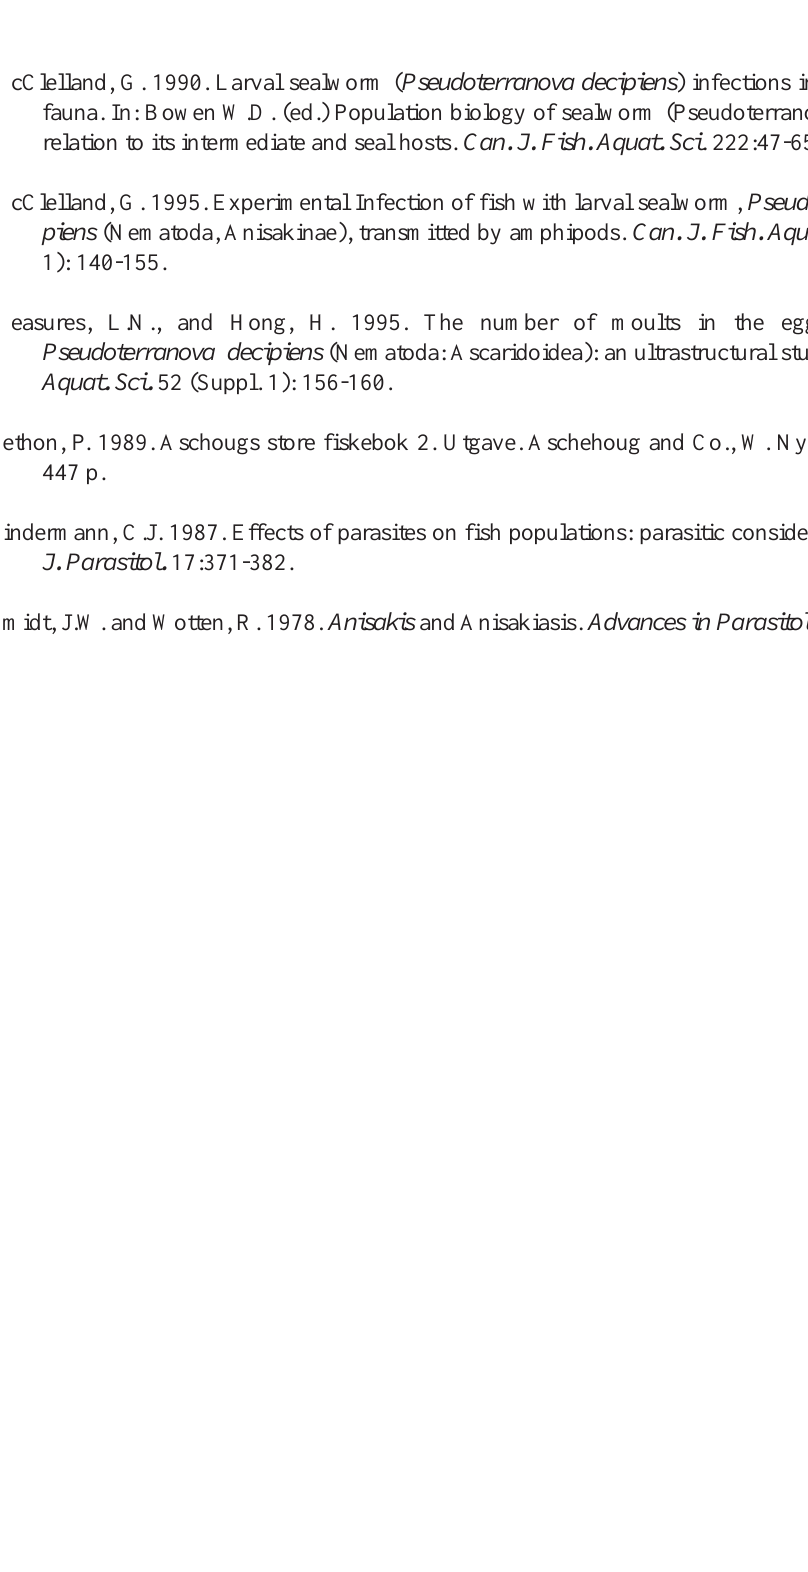
Sealworms in the North Atlantic : Ecology and Population